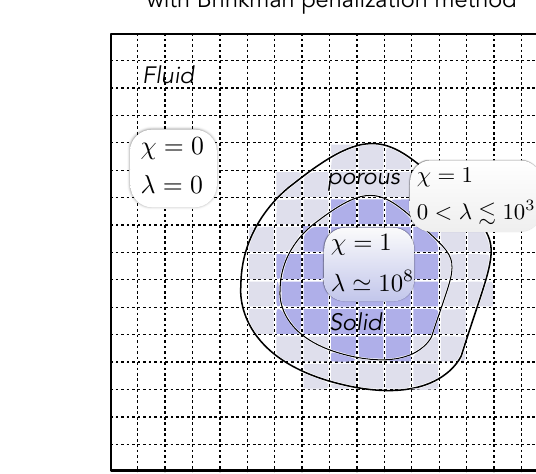
Figure 8. Schematic representation of the physical description ( left ) and its numerical parametrization ( right ) for flow past a solid-porous body using the Brinkman penalization